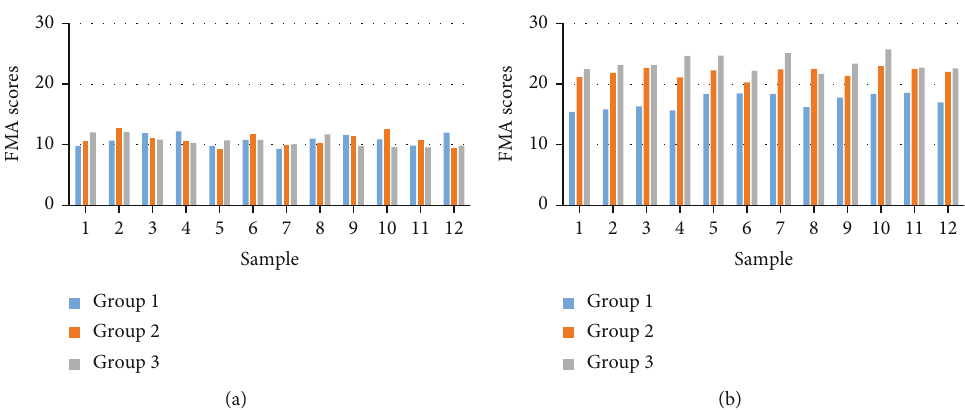
Figure 9: Motor function of lower limbs before and after treatment. (a) The FMA score of lower limb motor function before treatment in group 1, group 2, and group 3. (b) The FMA score of lower limb motor function after treatment in group 1, group 2, and group 3.